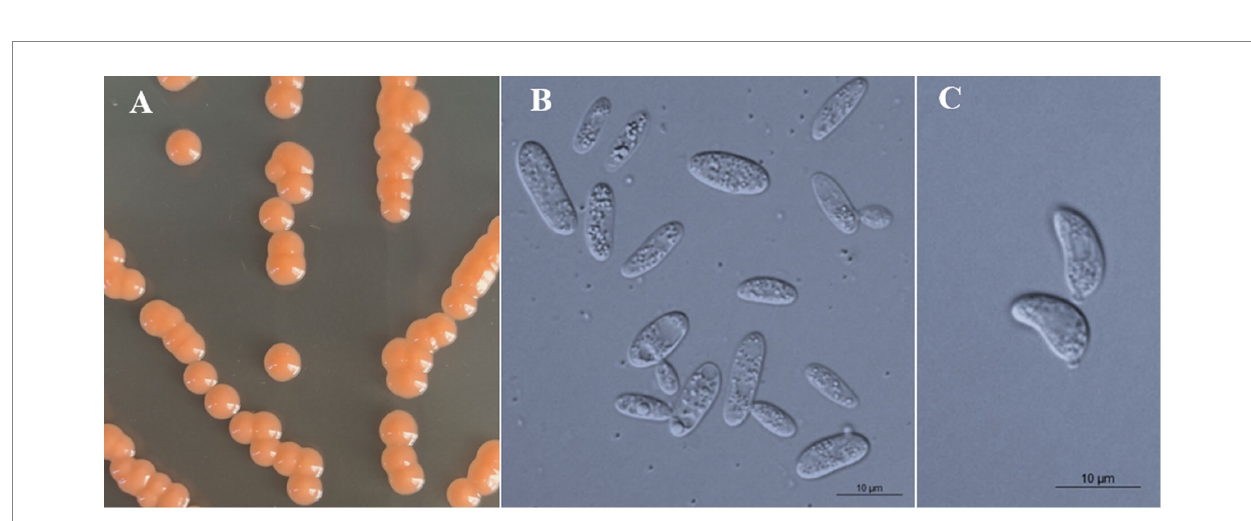
FIGURE 5 Morphological characteristics of Bannoa pseudofoliicola sp. nov. (GDMCC 2.270, holotype). (A) Colony morphology on YM agar after growth for 7 d at 25 ° C. (B) Budding cells after growth for 7 d in YM broth at 25 ° C. (C) Ballistoconidia on CM agar after growth for 7 d at 25 ° C. Scale bars = 10 μ